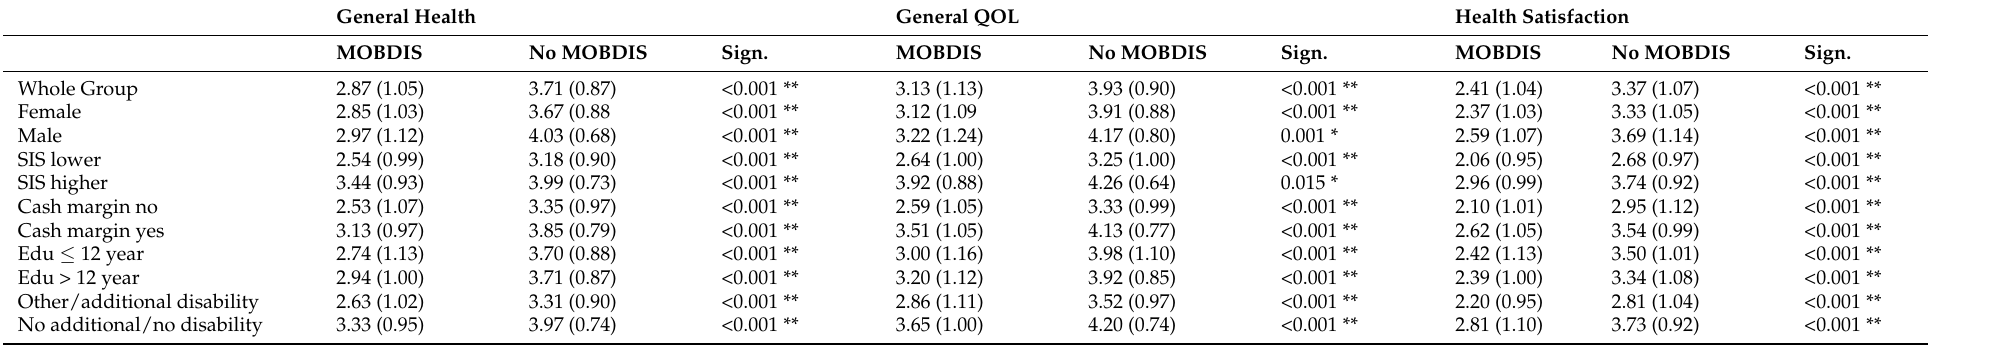
Table 2. Between-group comparison for WHOQOL-BREF items, [mean (SD)] p -value for Welch t-test (two-sided).